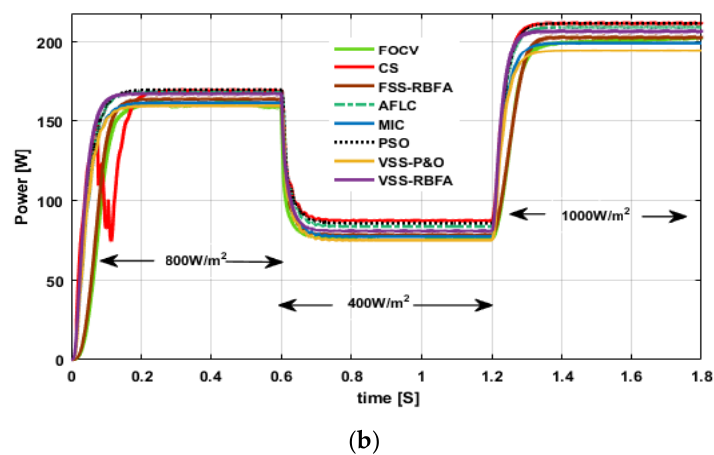
Figure 18. ( a ) Duty cycle of SCBC by applying different MPPT techniques at (0.8, 0.4, and 1 kW/m 2 ) and ( b ) output power of SCBC by applying different MPPT techniques at (800, 40, and 1000 W/m 2 ). Table 7. Performance results of SCBC at different irradiation conditions (800, 400, and 1000 W/m 2 ). MPPT